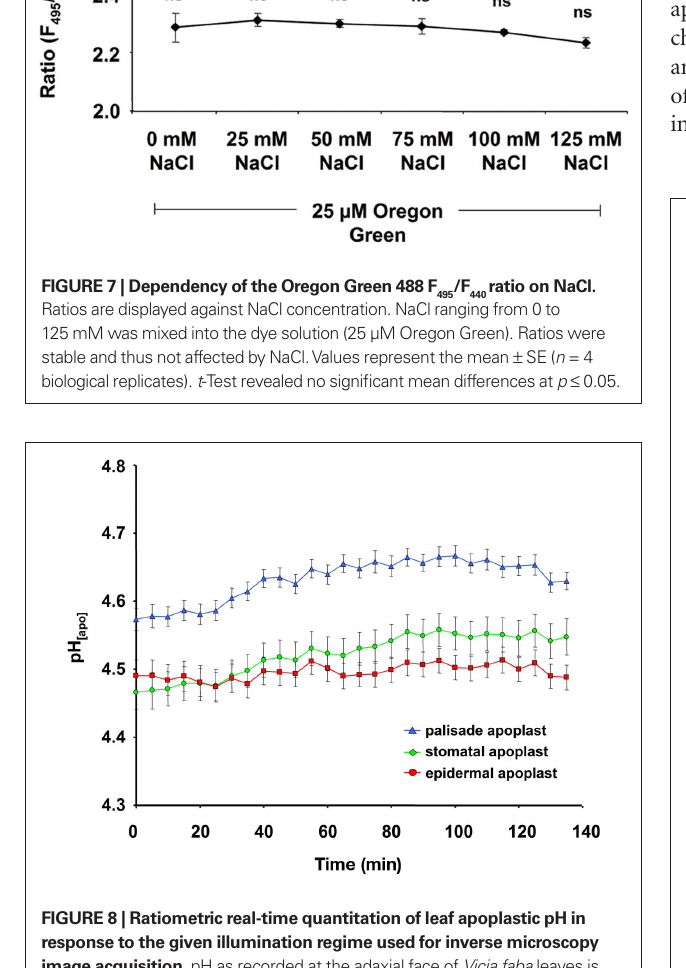
Figure 8 | ratiometric real-time quantitation of leaf apoplastic pH in response to the given illumination regime used for inverse microscopy image acquisition. pH as recorded at the adaxial face of Vicia faba leaves is plotted over time. Leaf apoplastic pH was discriminated within three apoplastic components, viz. in the stomatal cavity ( n = 6 ROI; green kinetic; mean ± SE of ROIs), in the epidermal apoplast ( n = 20 ROI; red kinetic; mean ± SE of ROIs) and in the apoplast surrounding the palisade mesophyll ( n = 2 0 ROI; blue kinetic; mean ± SE of ROIs). No effects on apoplastic pH were detected that were attributable to the illumination of the specimen with the excitation or emission wavelengths used for imaging. Representative kinetics of four equivalent recordings of plants gained from independent experiments.